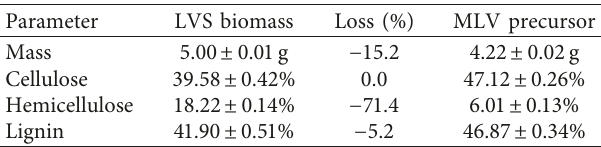
Table 1: Biochemical properties of the initial LVS biomass and MLV precursor after alkaline pretreatment (1% Na 2 CO 3 and 1% NaCl, 4h, rpm 150, normal